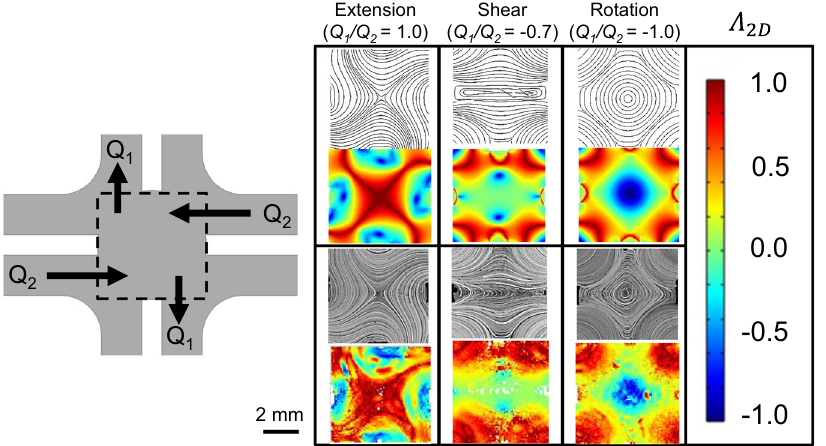
Figure 4. Streamlines (upper) and local 2D flow type parameter ( Λ 2 D , lower) comparisons between simulated (top) and experimentally determined (bottom) flow of glycerol (Newtonian fluid) in the center plane of the FFoRM geometry. All tests correspond to conditions with constant Q 2 = 0.5 mL/min ( Re = 0.0025) and the values of Q 1 /Q 2 indicated. Experimental conditions correspond to 〈 Γ  〉 ~0.5 s − 1 for extension, ~0.25 s − 1 for shear, and ~0.2 s − 1 for rotation. The device geometry is included on the left with the region of interest for PTV experiments outlined for reference.